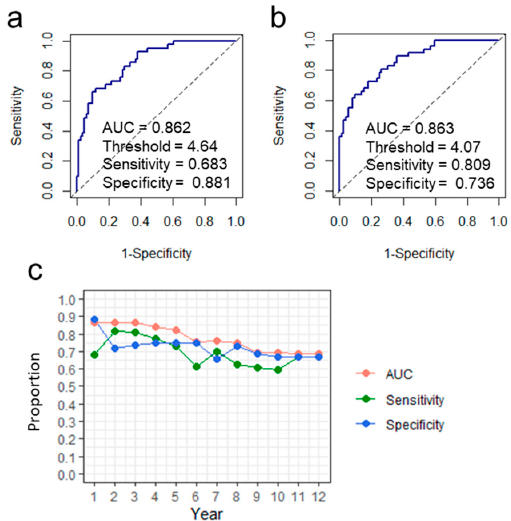
Figure 4. Results from the ROC analysis. ROC for the case of discriminating between patients who would develop HCC within 1 year and those who would develop HCC later or not ( a ). ROC for the case of discriminating between patients who would develop HCC within 3 years and those who would develop HCC later or not ( b ). AUC, sensitivity, and specificity obtained from the ROC analysis for the case of discriminating between patients who would develop HCC within the specified number of years and those who would develop HCC later or not ( c ).